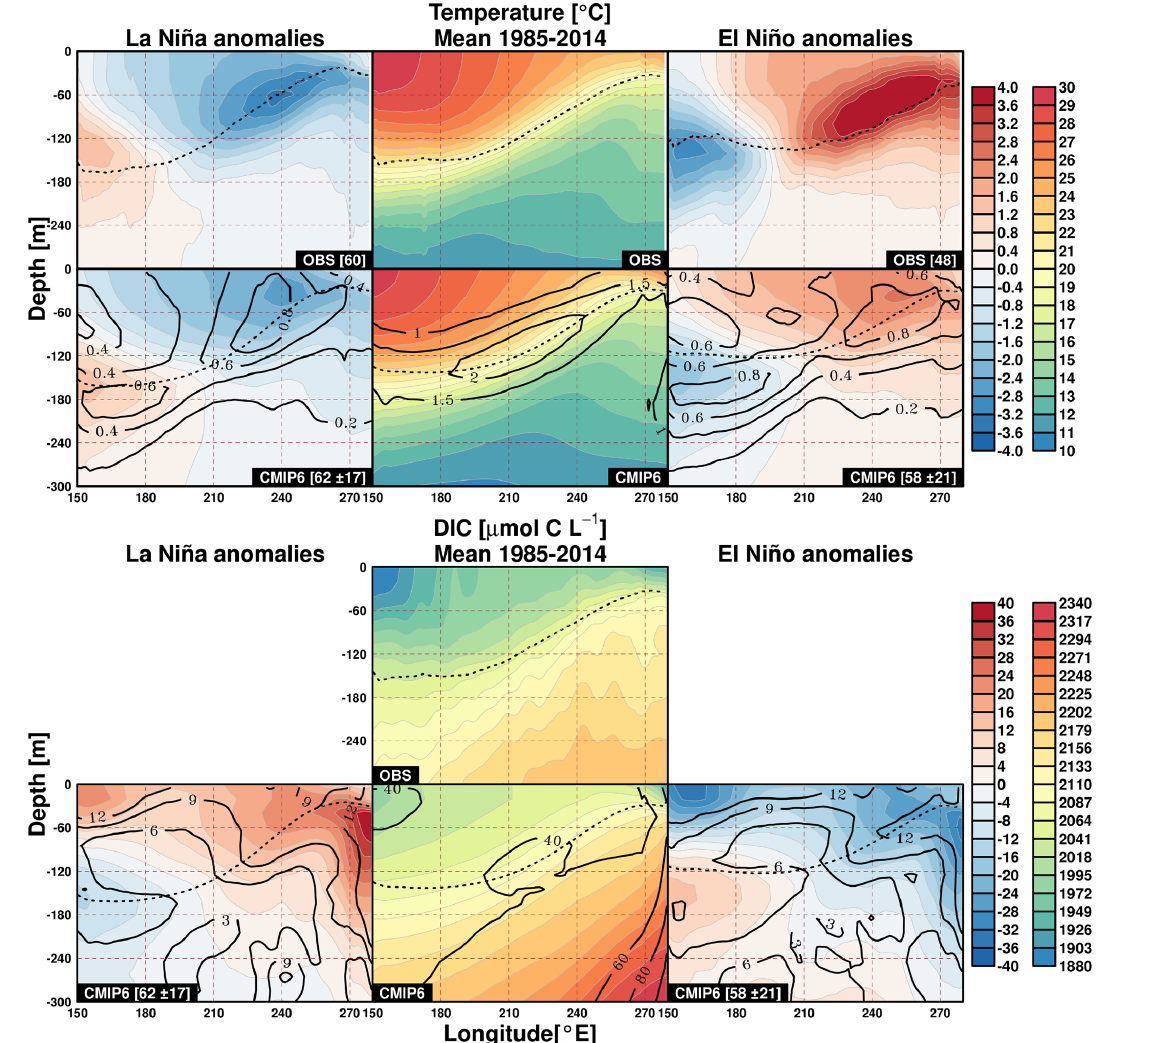
Figure 3. Observed and mean CMIP6 vertical sections of temperature (in ◦ C, top) and DIC (in µmolCL − 1 , bottom) as a zonal (between 2 ◦ N and 2 ◦ S) average over the 1985–2014 contemporary period (middle column). The average anomalies (differences) relative to contemporary mean are given for the La Niña (left) and El Niño (right) regimes. Note that the observed DIC average represents the climatology over the 2004–2017 period. Dotted lines indicate the average thermocline depth. In square brackets, the number of months in each regime is given for the observations and the mean number (with 1SD) is given for the CMIP6 ensemble. Black contours represent the standard deviation of the CMIP6 inter-model ensemble anomalies during each ENSO